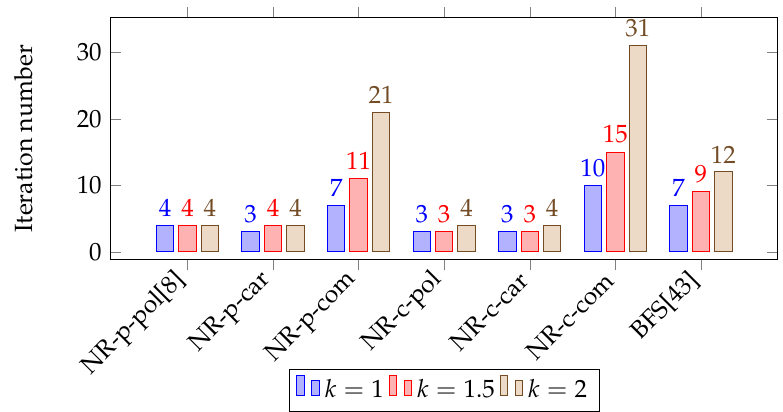
Figure 5. Convergence results for different loading conditions ( S = k ∗ S ) in DCase69.